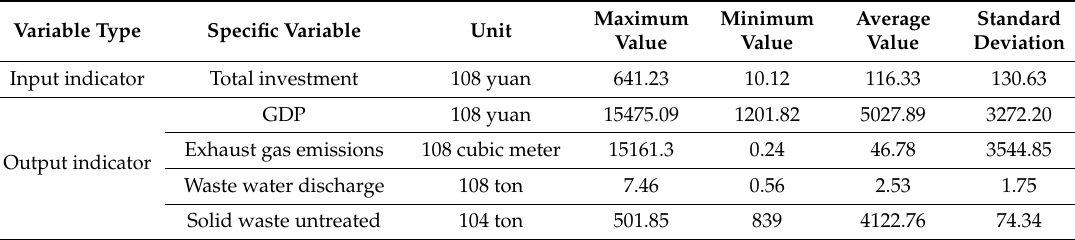
Table 2. Descriptive statistical characteristics of input-output variables in